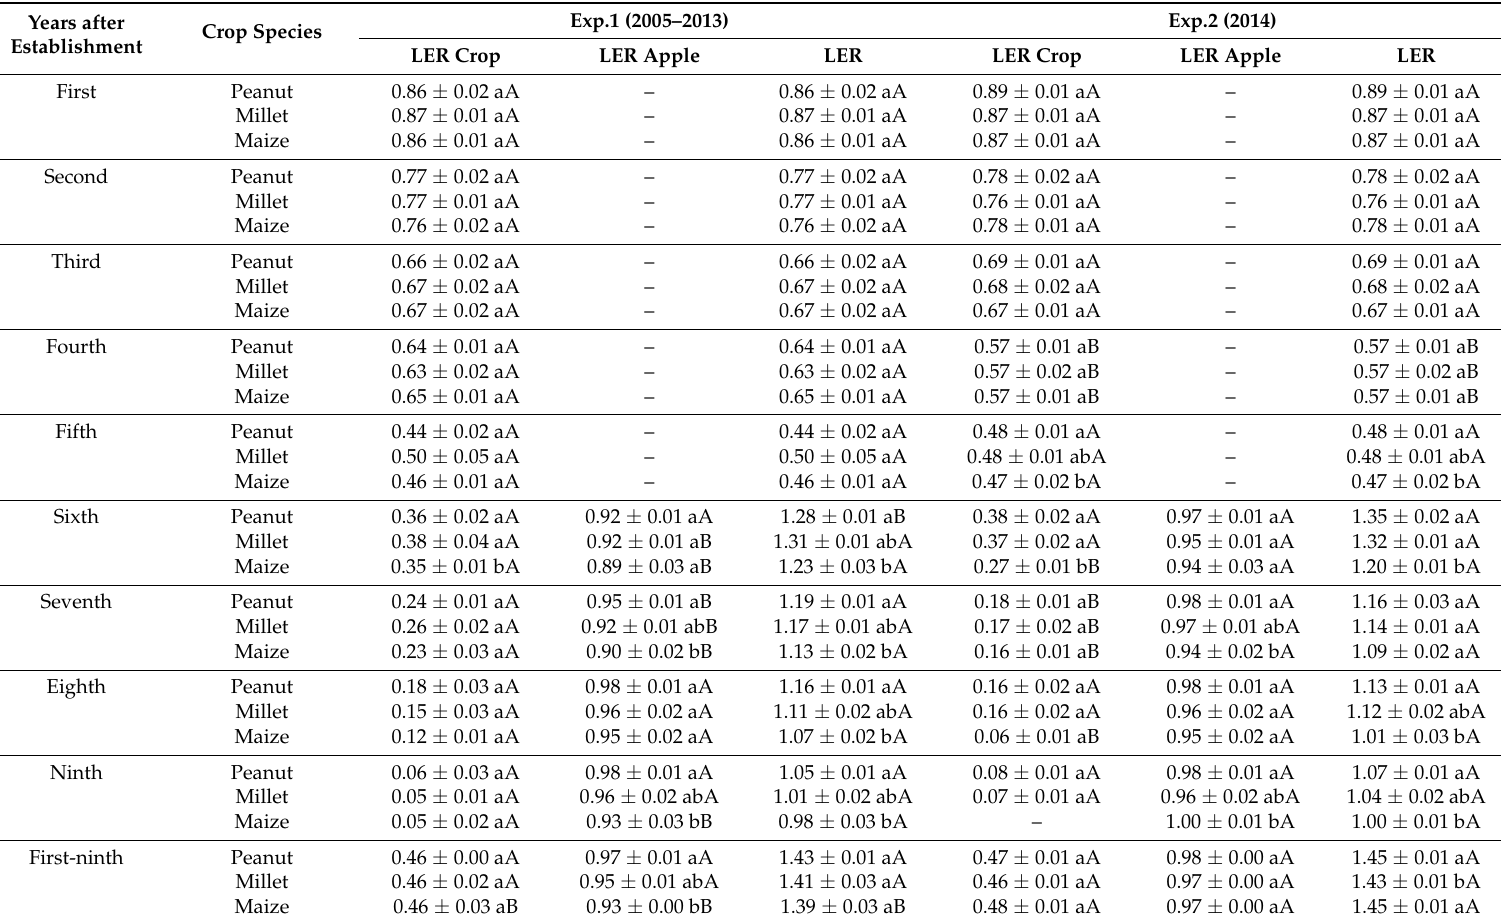
Table 3. Land equivalent ratios (LER) in apple-based alley cropping systems in Exp.1 and